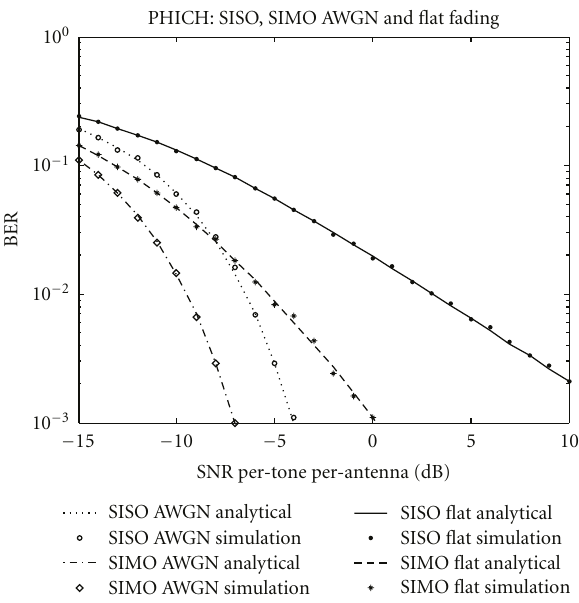
Figure 4: E ff ect of channel estimation error in PHICH. Figure 5: PHICH performance in SISO and SIMO